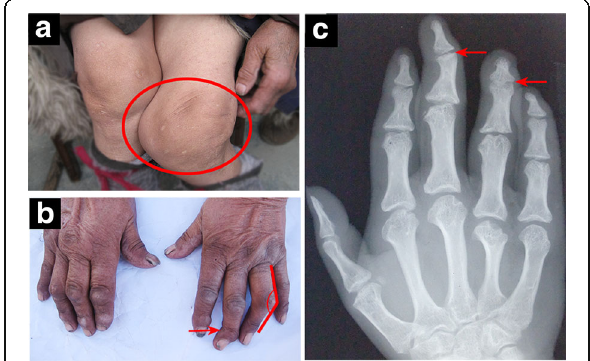
Fig. 1 Clinical features of patients with Kashin-Beck disease (KBD). a and b A patient with KBD shows obvious flexion and extension in the knees ( circled area ) and inter-phalangeal joints ( arrow and angle labeled area ), with deformity and limited mobility. c The x-ray radiographs of